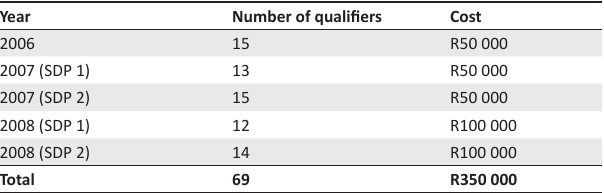
TABLE 4: Approximate supervisory development programme cost and number of qualifiers from 2006 to 2008.